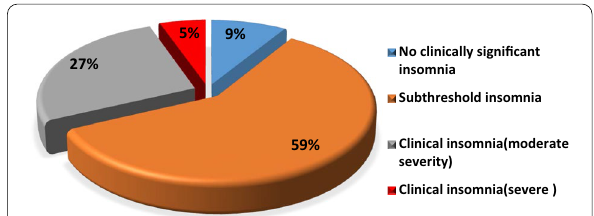
Fig. 1 Distribution of the patients according to insomnia severity index